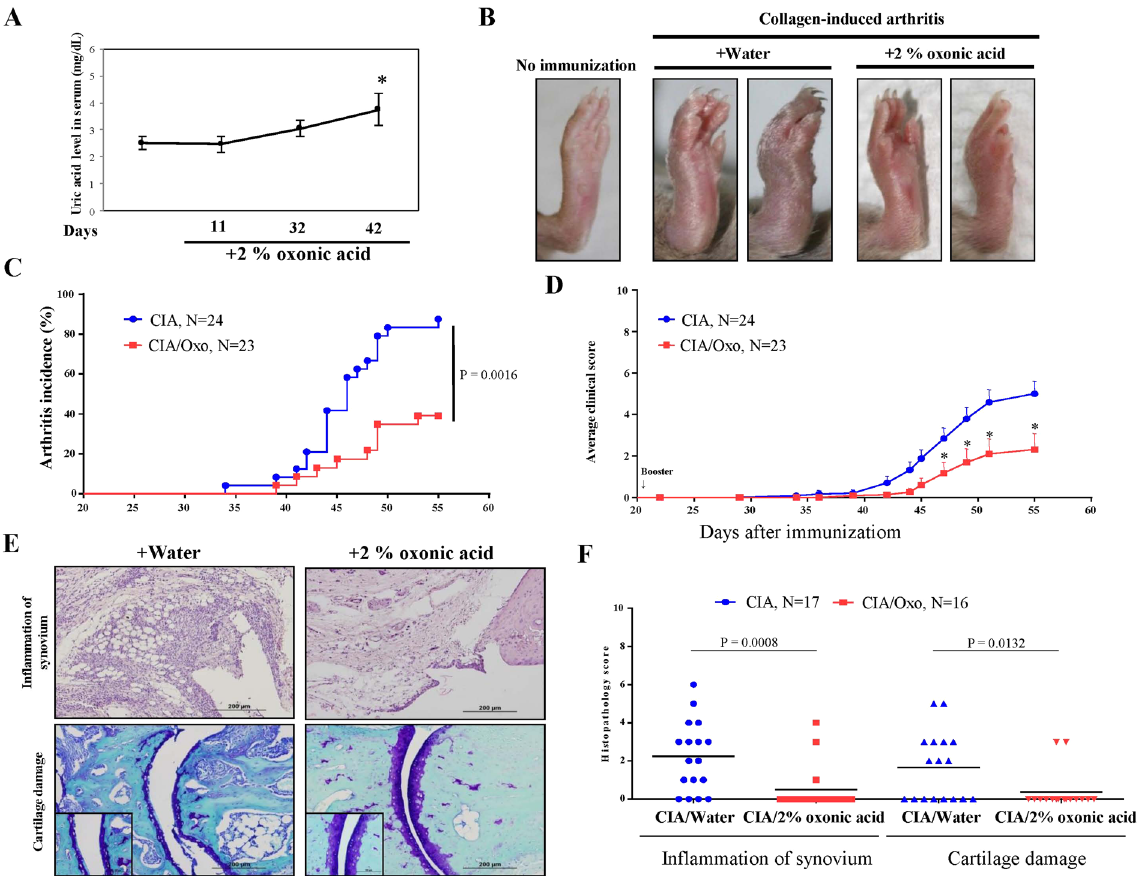
Figure 6. Effects of sUA on mice with collagen-induced arthritis. Three individual independent experiments were conducted sequentially, and the results of the experiments were pooled for analysis. Each independent experiment comprised solvent (water)-treated and oxonic acid-treated mice (average, 8–9 animals each). ( A ) Shows the relationship between serum uric acid concentrations and the interval after oxonic acid treatment. ( B ) Shows representative images of arthritis in water- and oxonic acid-treated mice. The incidence of arthritis ( C ) and average clinical scores ( D ) were calculated for the control and oxonic acid-treated groups. The results of the immunohistochemical analysis of joint tissue specimens were analysed. ( E ) Shows representative images of synovial inflammation and cartilage damage, and ( F ) shows the histopathology scores. The numbers of animals involved in individual analyses are